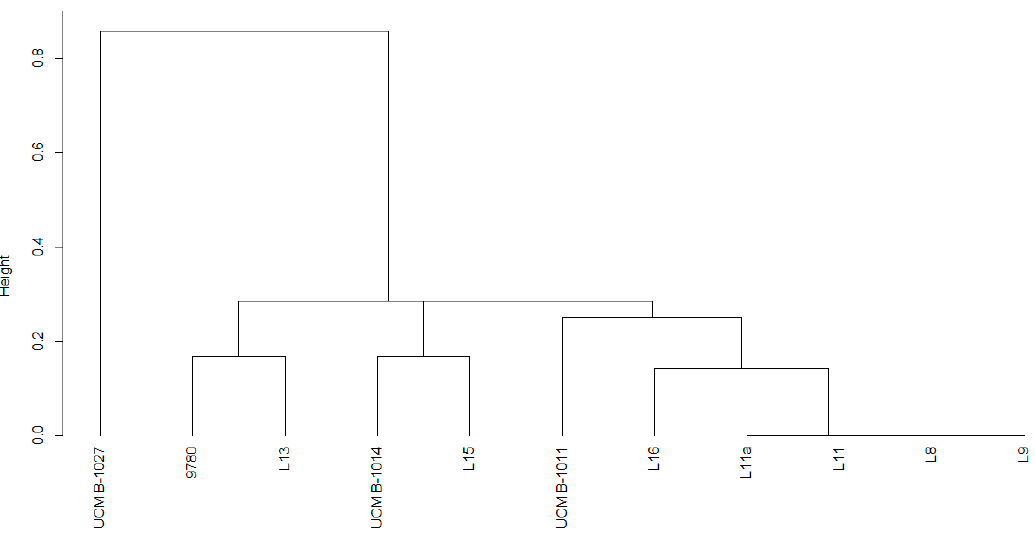
Figure 5. Cluster analysis of RAPD patterns obtained with primer OPA-13 of Pseudomonas syringae strains (Jaccard distance, the nearest neighbor clusterization method).